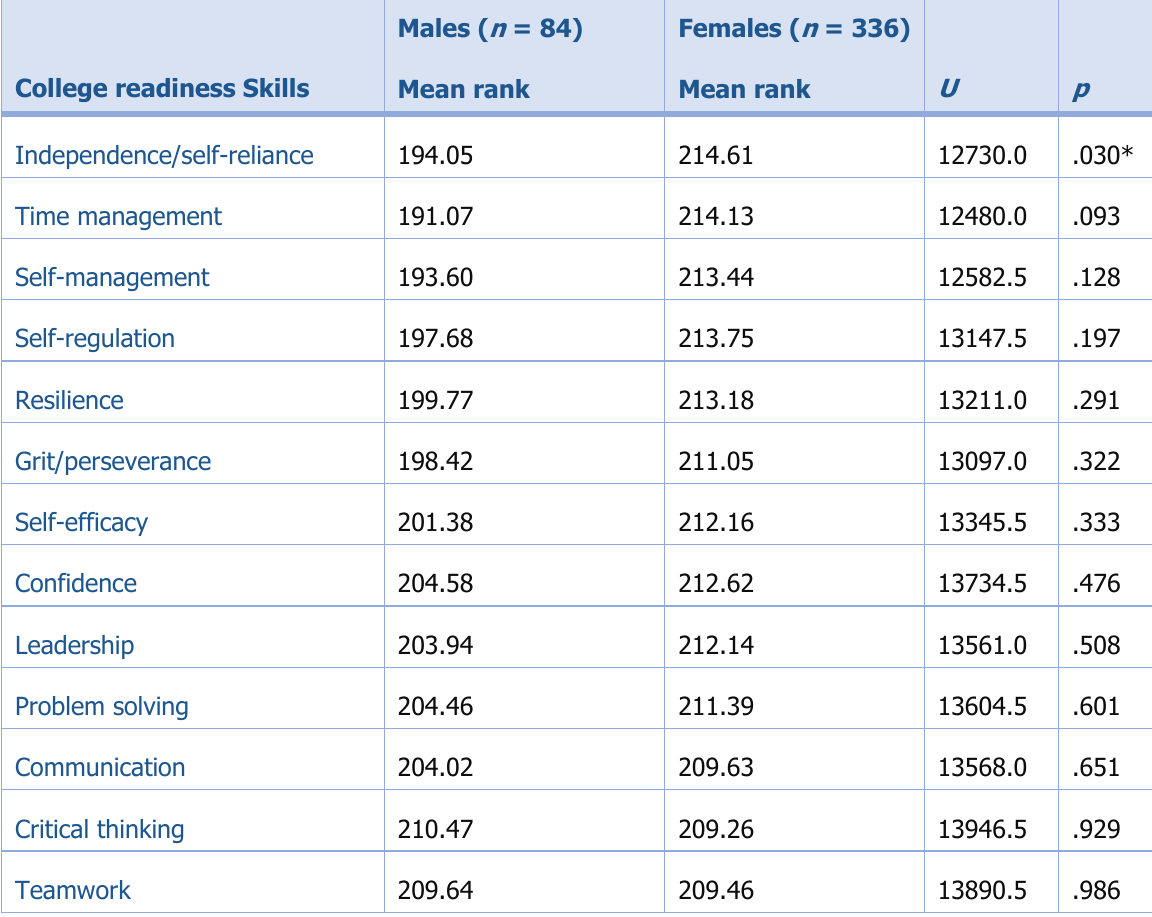
Table 3. Mann-Whitney U Comparisons for Gender and College Readiness